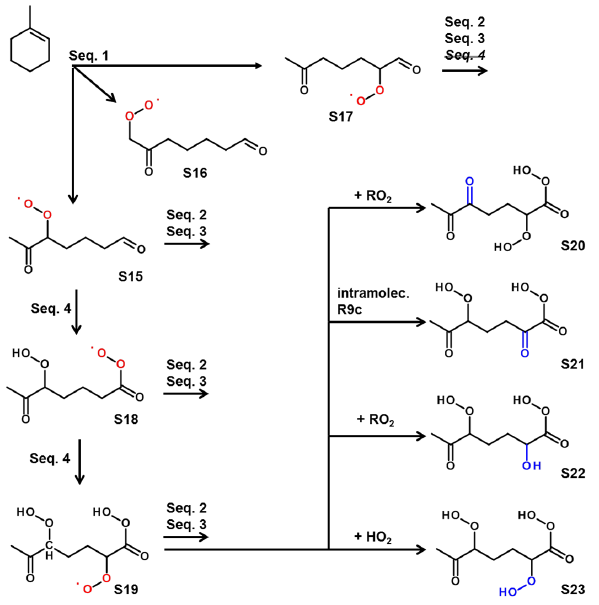
Figure 5. Schematics of HOM formation of 1-methyl cyclohexene. The major products are carbonyl termination products, either S20 or S21. Higher oxidation products are minor. Peroxy radical S17 has no terminal ω -aldehyde group. Peroxy radical S16 will produce isobaric products analogous to S15.